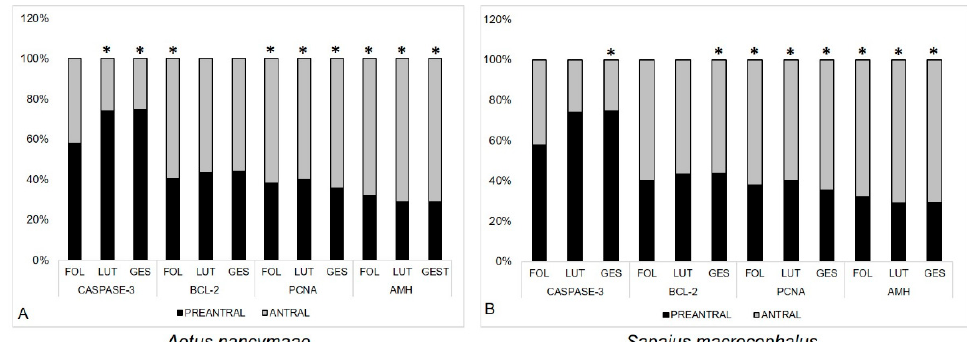
Figure 2. Percentage of follicles (preantral and antral) immunostained for Caspase-3, BCL-2, PCNA, and AMH, according to the sexual phases (FOL—follicular, LUT—luteal and GES—gestational). ( A ) Ma’s night monkeys ( Aotus nancymae , n = 6) and ( B ) head-large capuchins ( Sapajus macrocephalus , n = 6). (*) indicate that there is a statistically significant difference between preantral and antral follicles, according to the stage (Binomial Test. p < 0.01).